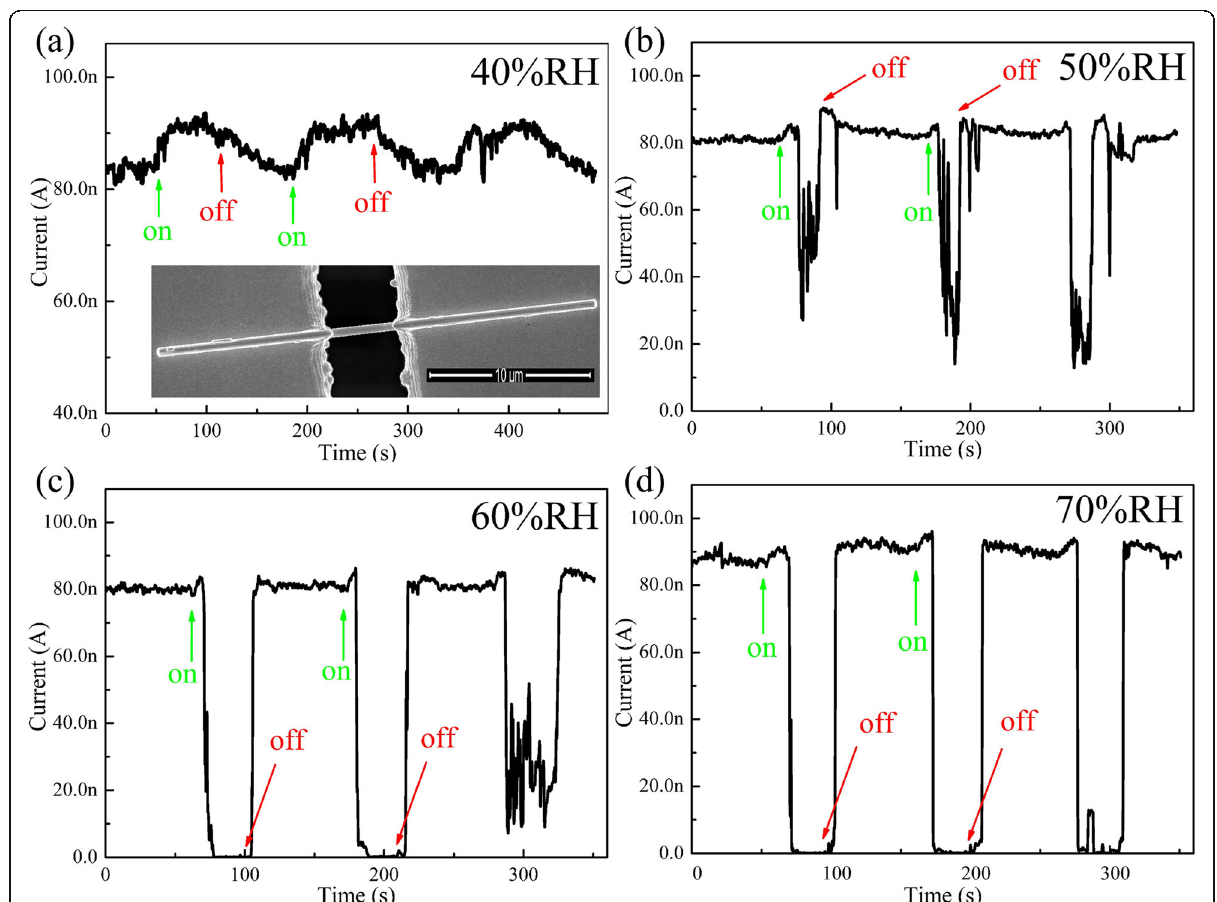
Fig. 1 Typical I-T curves ( V ds = 3 V) of an Au/h-WO 3 NW/Au device recorded repeatedly with laser (445 nm, 500 mW) on and off under 40%RH ( a ), 50% RH ( b ), 60% RH ( c ), and 70% RH ( d ). The lower inset of a : SEM image of an Au/h-WO 3 NW/Au device, the nanowire between two electrodes with a diameter of about 300 nm, and a length of about 4 μ